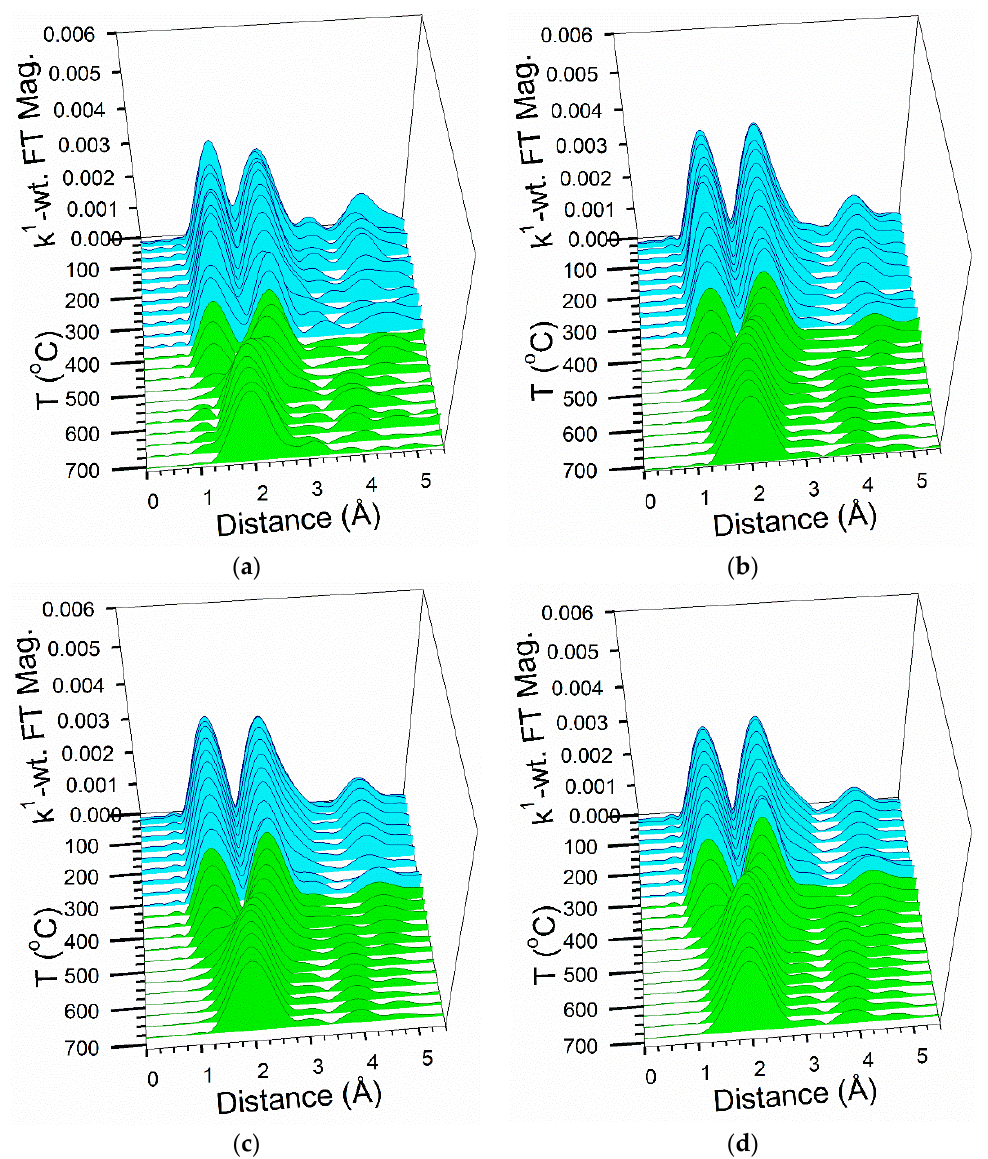
Figure 15. H 2 -TPR-EXAFS spectra at the Ni K-edges of ( a ) 25%M (M = 5%Ni-95%Co)/Al 2 O 3 , ( b ) 25%M (M = 10%Ni-90%Co)/Al 2 O 3 , ( c ) 25%M (M = 25%Ni-75%Co)/Al 2 O 3 , and ( d ) 25%M (M = 50%Ni-50%Co)/Al 2 O 3 . (Cyan) is Ni 2+ (e.g., NiO) associated with cobalt oxides during reduction of Co 3 O 4 to CoO. (Green) is reduction of Ni 2+ to Ni 0 when NiO reduction is associated with CoO reduction to Co 0 .